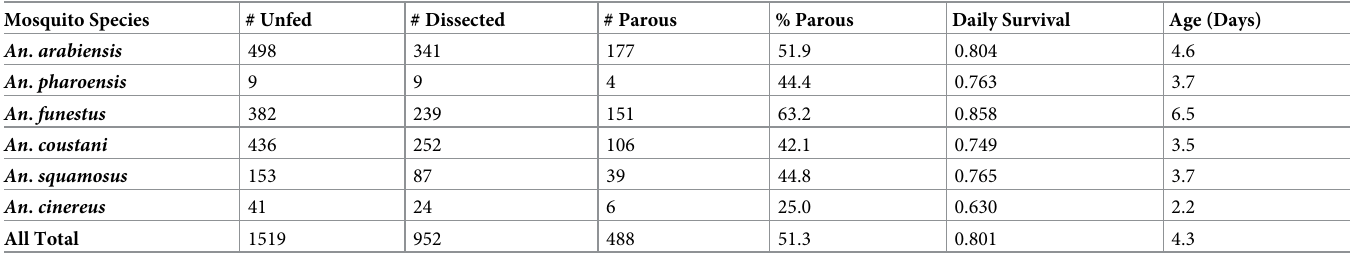
Table 1. Parous rates and longevity of Anopheles mosquitoes caught by LTCs in Bure district, Ethiopia. Mosquito Species